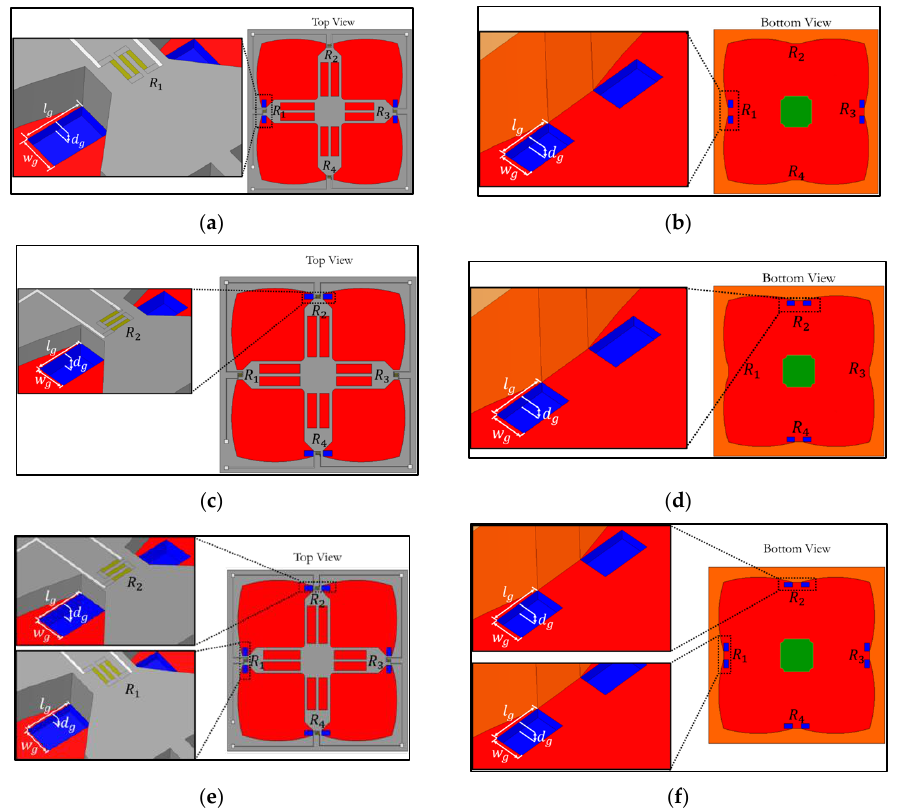
Figure 3. Local groove design 2: ( a ) grooves on top of diaphragm at longitudinal piezoresistors (𝐿𝐺2 − 𝐿0 − 𝑇𝑜𝑝) , ( b ) grooves at bottom of diaphragm at longitudinal piezoresistors (𝐿𝐺2 − 𝐿0 − 𝐵𝑜𝑡𝑡𝑜𝑚) , ( c ) grooves on top of diaphragm at transverse piezoresistors (𝐿𝐺2 − 0𝑇 − 𝑇𝑜𝑝) , ( d ) grooves at bottom of diaphragm at transverse piezoresistors (𝐿𝐺2 − 0𝑇 − 𝐵𝑜𝑡𝑡𝑜𝑚) , ( e ) grooves on top of diaphragm at both longitudinal and transverse piezoresistors (𝐿𝐺2 − 𝐿𝑇 − 𝑇𝑜𝑝 ) and ( f ) grooves at bottom of diaphragm at both longitudinal and transverse piezoresistors (𝐿𝐺2 − 𝐿𝑇 − 𝑏𝑜𝑡𝑡𝑜𝑚 ). (Note: not to scale.)